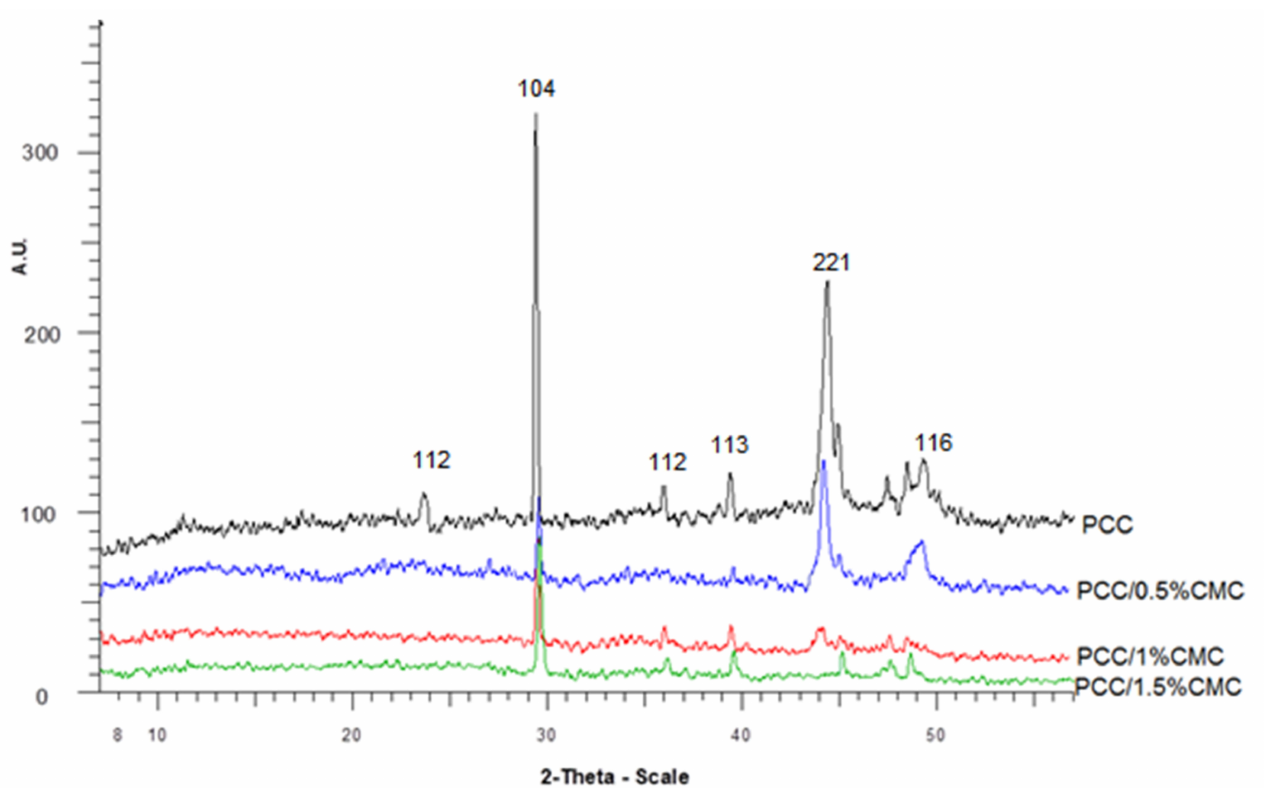
Figure 4. XRD patterns of PCC and